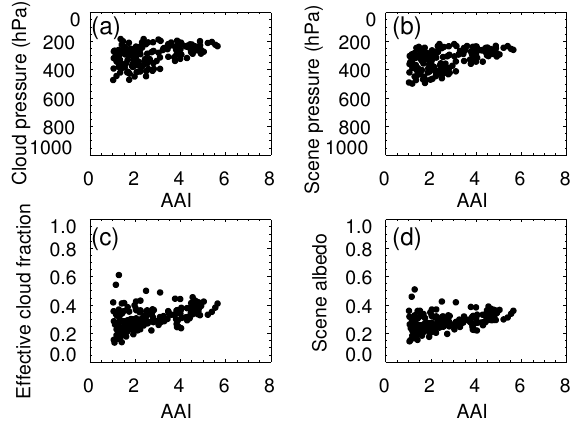
Fig. 13. Scatter plots of FRESCO (a) cloud pressure, (b) scene pres- sure, (c) effective cloud fraction, and (d) scene albedo versus ab- sorbing aerosol index (AAI) from GOME-2 measurements of the Puyehue volcanic ash plume on 6 June 2011 around 10:45UTC. The pixels used in the scatter plots are marked with the right box in Fig. 11 in the region of [25, 45] ◦ S and [25, 35] ◦ W.